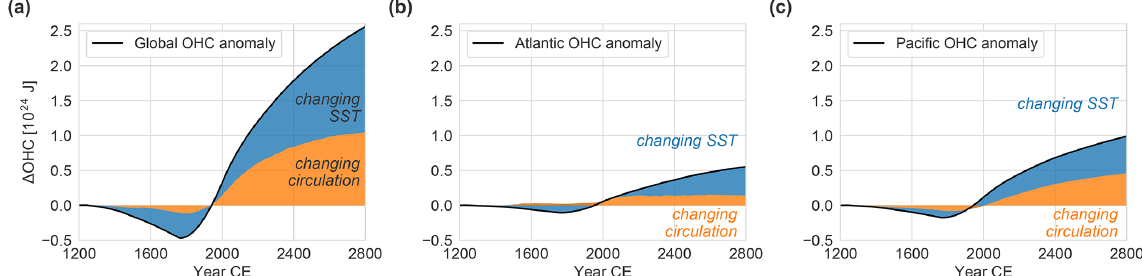
Figure 7. Ocean heat content anomaly decomposed in contributions due to changing SST and due to changing circulation for (a) the global ocean, (b) the Atlantic and (c) the Pacific basin, derived from simulations OcTRA and